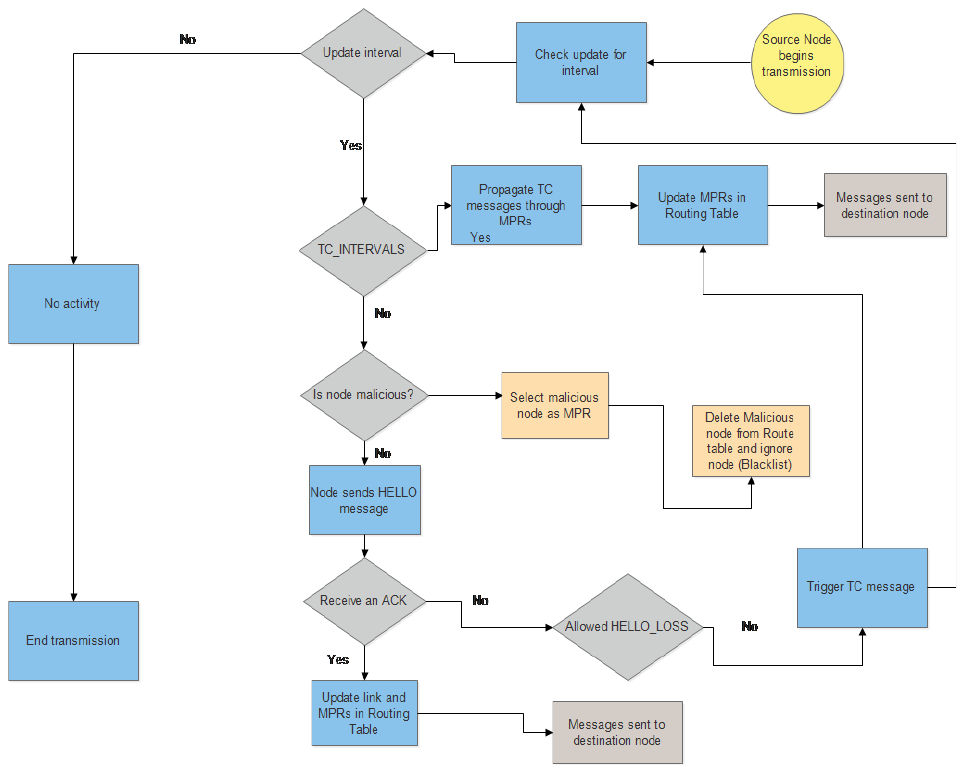
Figure 3. Modified OLSR flow chart [22].